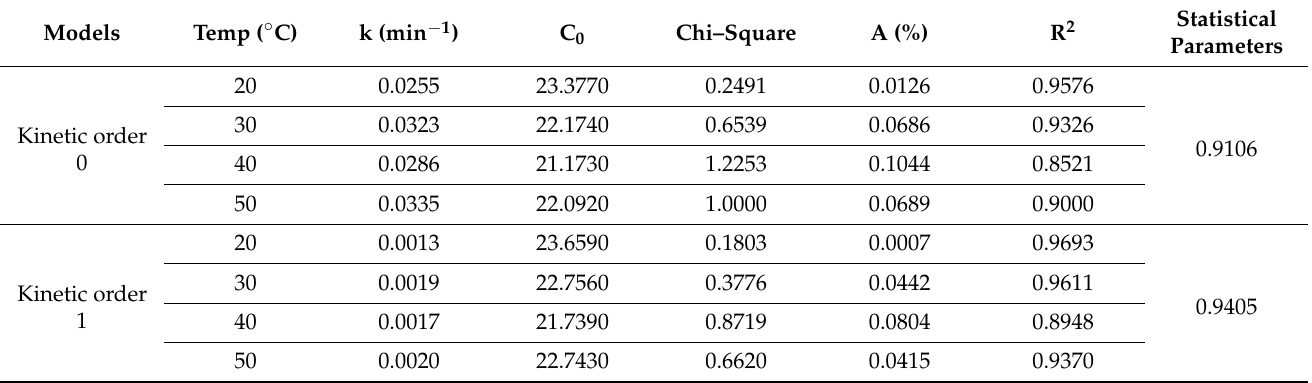
Table 4. Kinetic parameters of TPC decomposition in the heat pump drying